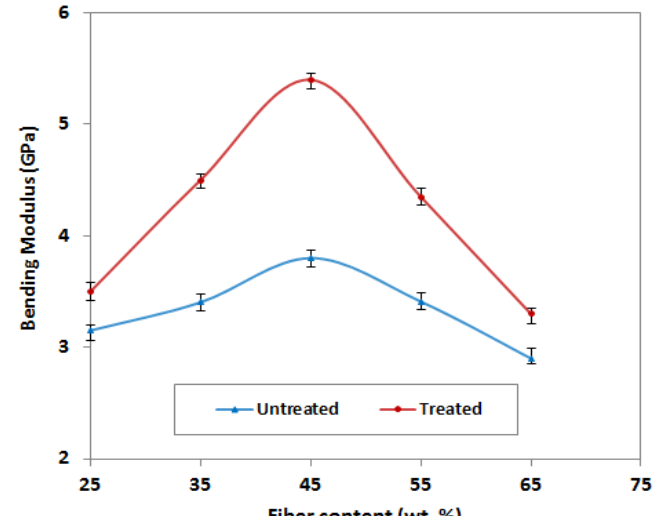
Figure 7: Comparison between bending modulus of the resultant composites with respect to fiber loading.